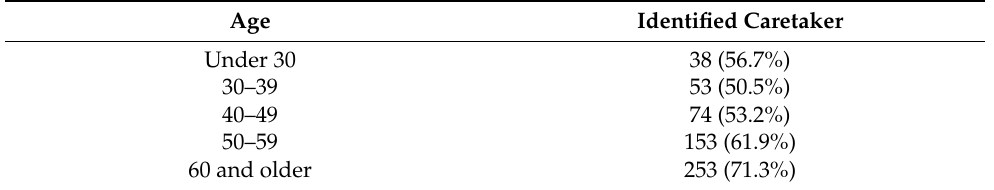
Table 4. Age as a factor in identified caretaker of cat ( n =